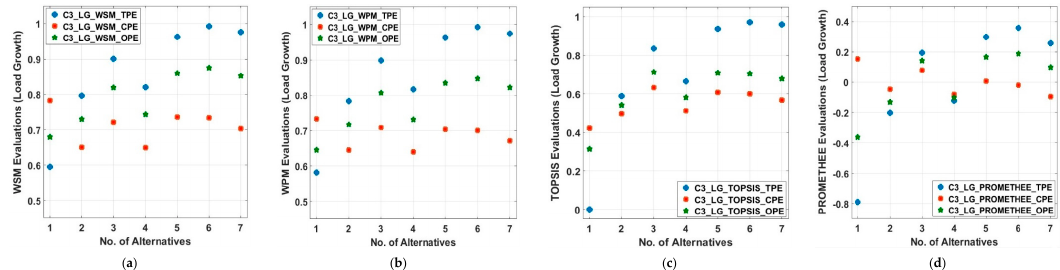
Figure 11. MCDM evaluations for C3_LG in 33-bus MDN: ( a ) WSM scores; (b) WPM scores; ( c ) TOPSIS scores; ( d ) PROMETHEE scores.